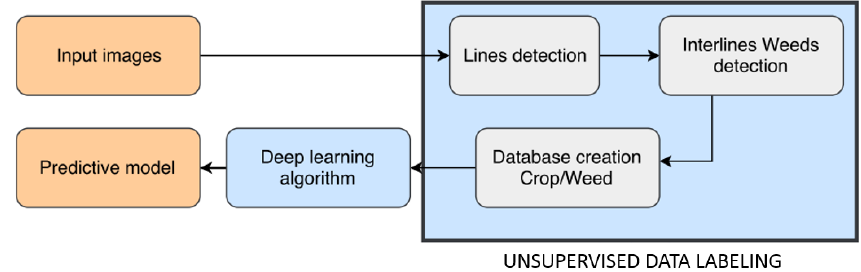
Figure 1. Flowchart of the proposed